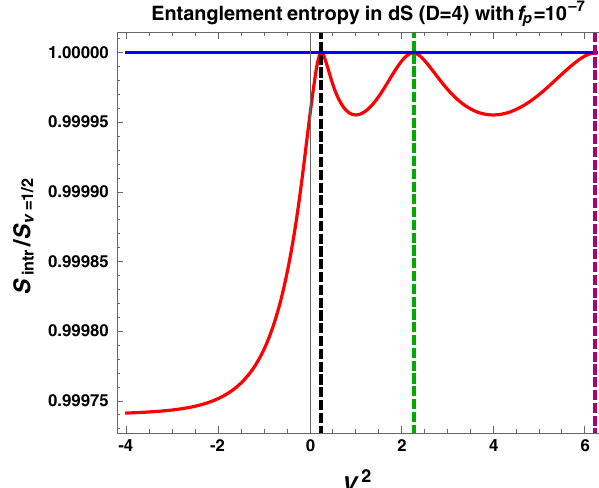
(b) Normalized entanglement entropy vs ν 2 in 3 + 1 D de Sitter space with axionic source ( f p = 10 − 7 ). ‘ + ’ branch of solution of | γ p | and | (cid:17) p , n | . Here we set (cid:14) C = 10 , 000. In both cases we have normalised the entanglement entropy with the result obtained from ν = 1 / 2, which is the conformal limit